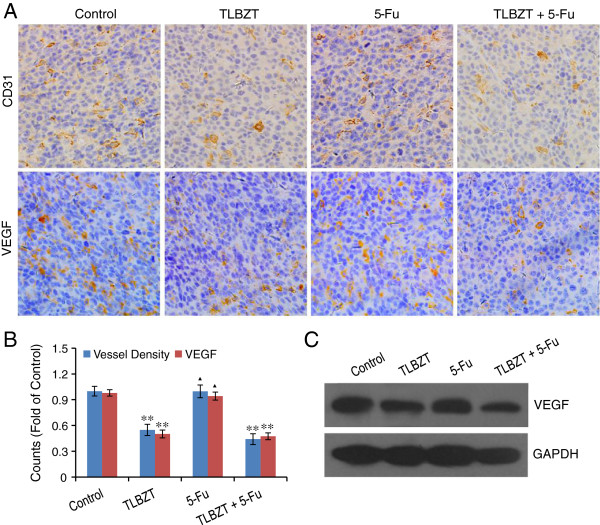
Effects of TLBZT and 5-FU on angiogenesis. A, after three weeks treatment, angiogenesis and VEGF expression in CT26 carcinomas (3 tumors/group) were detected by immunohistochemistry and observed under microscope (×200). B, vessel density was determined via counting the number of the microvessels per high-power field (3 HPF/slide), and the MOD of VEGF (3 HPF/slide) were analyzed by Image-Pro Plus 6.0 software, and expressed as fold over control. C, VEGF expression in CT26 carcinomas were further verified by western blot. GAPDH was used as a loading control. **P<0.01, versus control group. ▲P>0.05, versus control group.